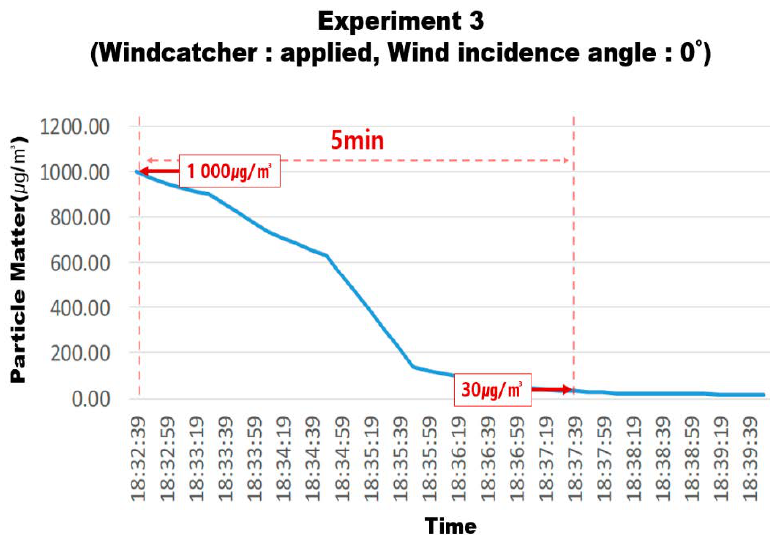
Figure 17. Results of Experiment 2.